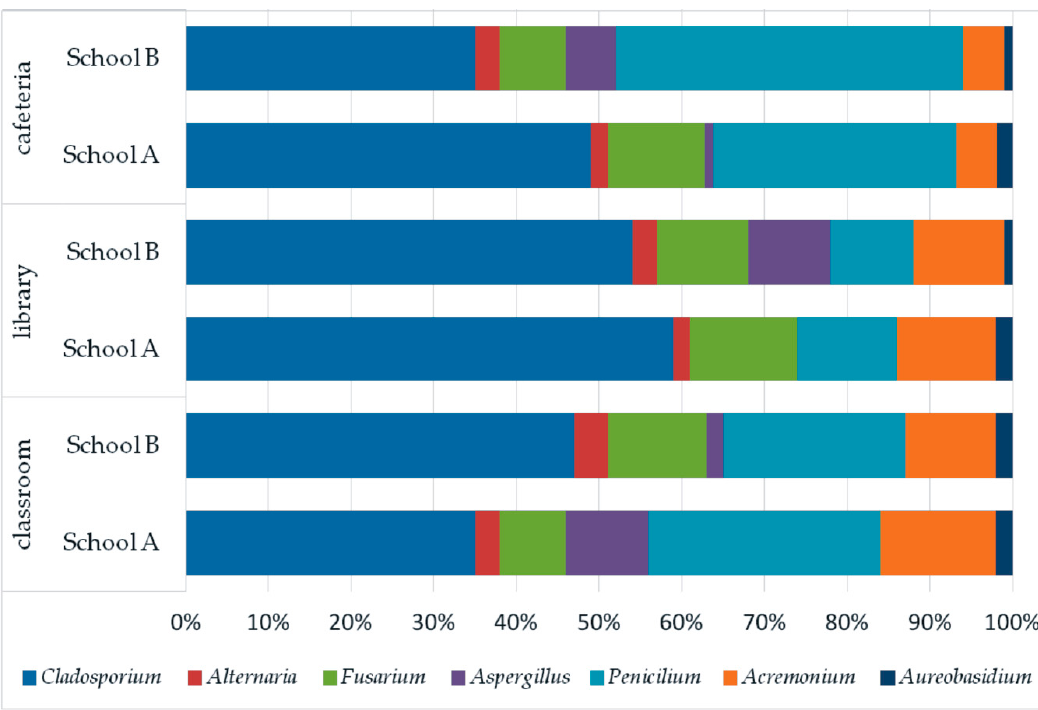
Figure 2. Predominant genera of airborne fungi at all sampling sites.